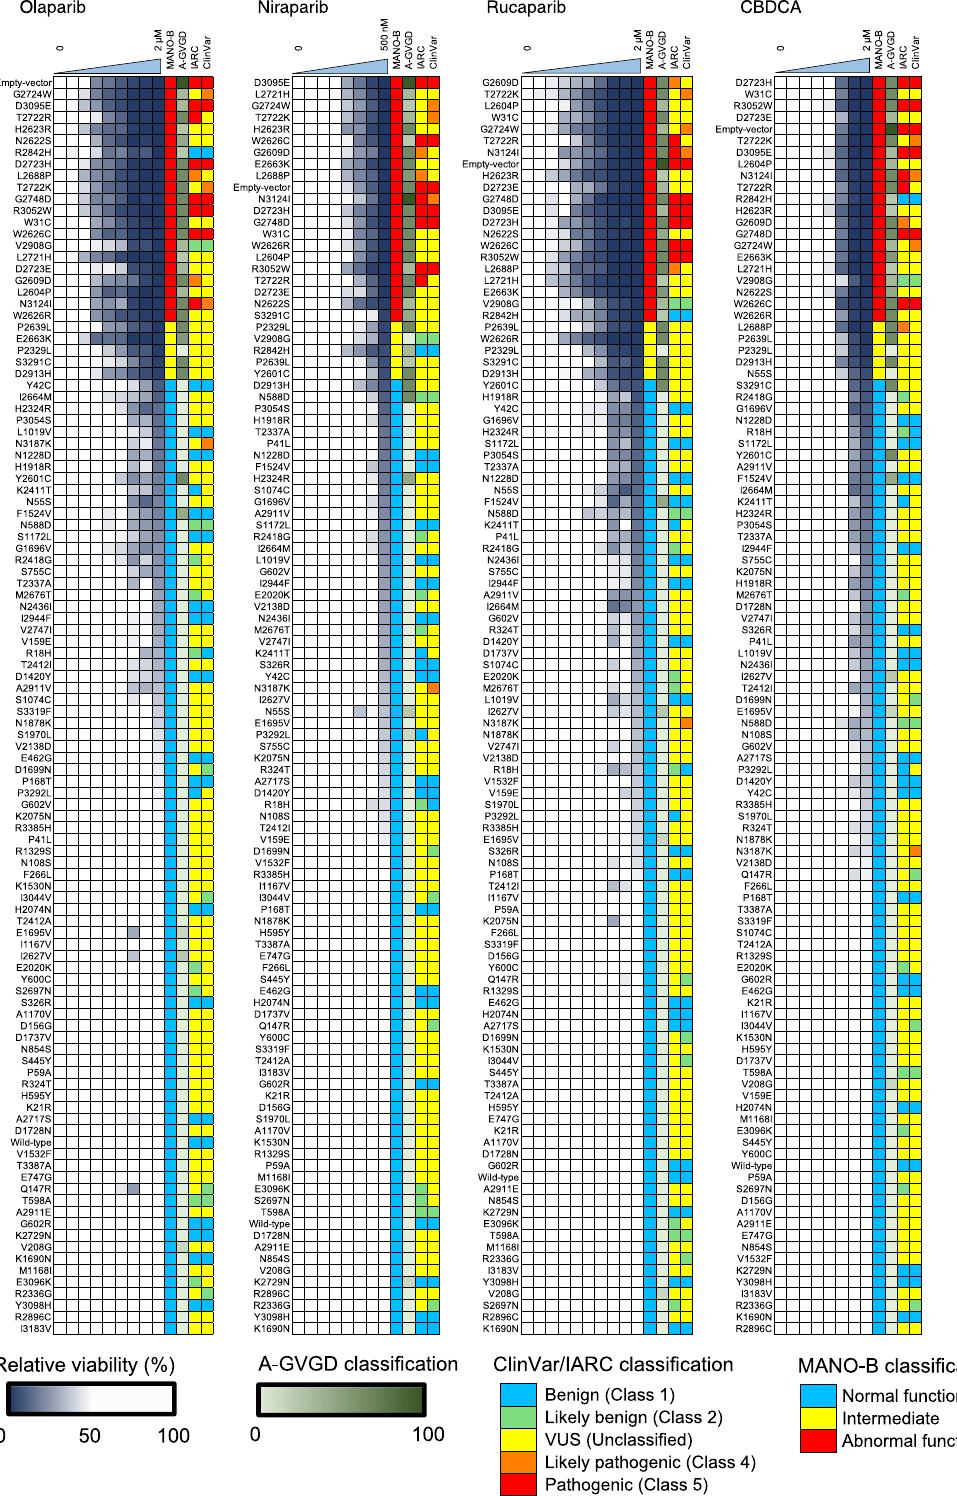
Fig. 2 Comparative results of the MANO-B method with the IARC, ClinVar, and Align-GVGD classi fi cations for 107 variants. DLD1 BRCA2 ( − / − ) cells transfected separately with the 107 BRCA2 variants or the empty vector were treated with PARP inhibitors (olaparib, niraparib, and rucaparib), CBDCA, or DMSO at the indicated concentrations. The relative viability of the cells treated with each drug was calculated based on the viability of vehicle-treated cells, then normalized to that of cells expressing wild-type BRCA2 . All variants were ordered by relative viability at the optimal concentration. The classi fi cation of the MANO-B method was based on the relative viability at the optimal concentration of each drug and de fi ned as normal (relative viability of 1 – 82), intermediate (83 – 87), and abnormal (88 – 108). The IARC, ClinVar, and Align-GVGD classi fi cations are color-coded in each column. The ClinVar classi fi cations of fi ve variants (V159E, M1168I, K1530N, G1696V, and A2911E) without assertion criteria were considered as